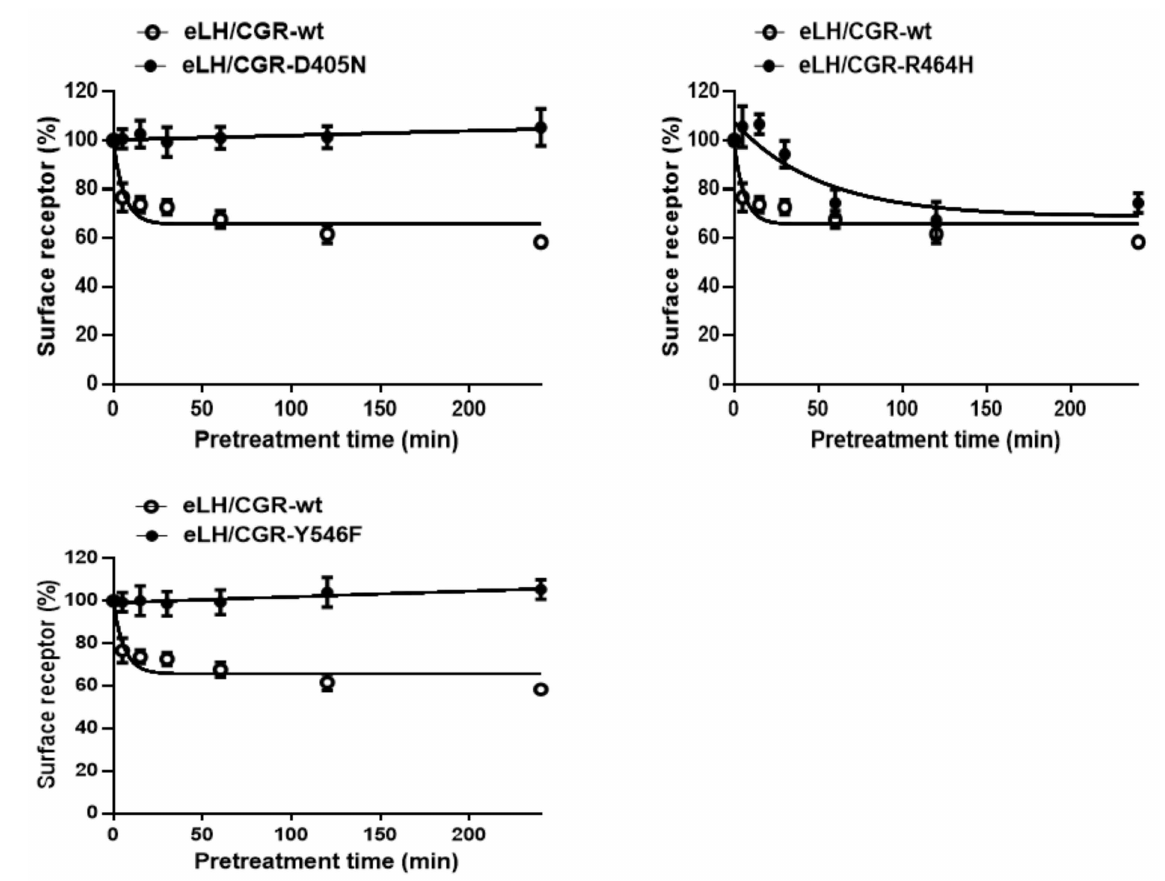
Figure 7. Time-dependent cell-surface loss in the wild-type eLH/CGR and inactivating eLH/CGR mutants. HEK-293 cells transiently expressing wild-type eLH/CGR or inactivating receptors (D405N, R464H, and Y548F) were incubated with 1000 ng/mL recombinant eCG (rec-eCG) for up to 240 min. Cell-surface expression in the non-pretreated groups was considered as 100% (see Materials and Methods for details). The loss of each receptor was determined using the GraphPad Prism software. The results are expressed as the means ± SE of three independent experiments. In this figure, the mean data are fitted to the one-phase exponential decay equation. The empty circles represent the corresponding curves for the wild-type